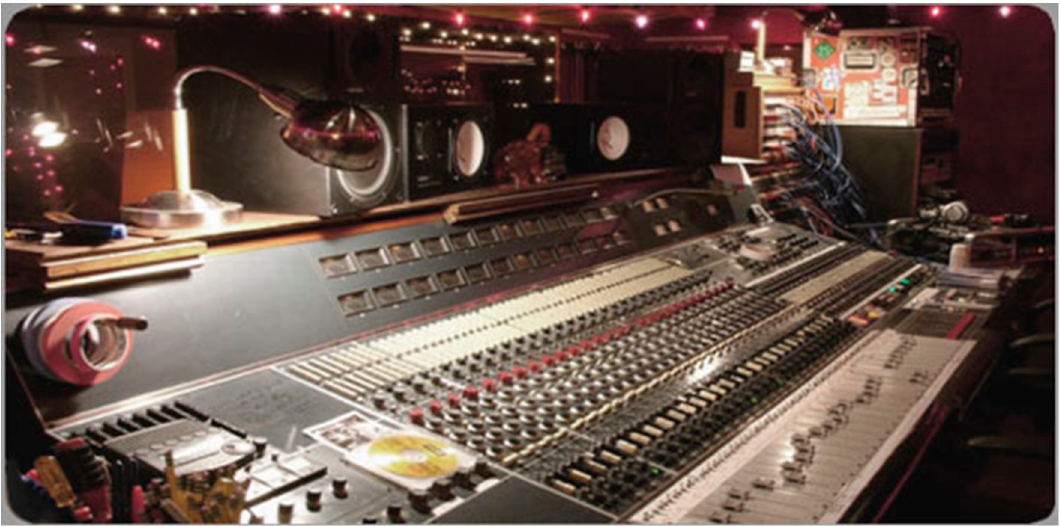
Figure 1. A Neve mixing console. Image (Sound City Studios 2013).